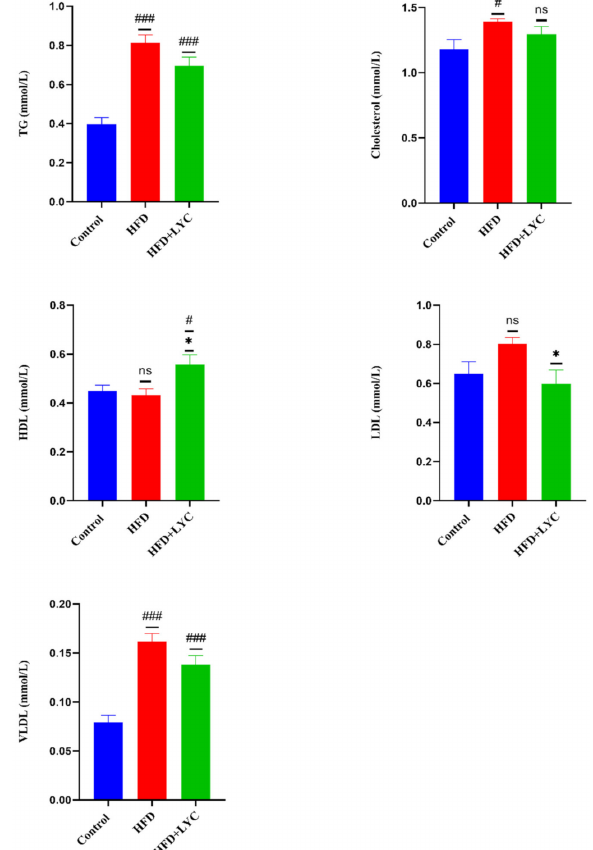
Figure 2. Serum levels of lipid profiles: TG, cholesterol, HDL, LDL, and VLDL, following treatment with LYC in rats fed an HFD. Data are expressed as the mean ± SEM of two replica ( n = 12 rats). Different markers correspond to statistically significant differences between groups. # p < 0.05 and ### p < 0.001 indicate significant and very highly significant compared to the control, respectively. * p < 0.05 indicates a significant difference compared to the HFD group. ns: